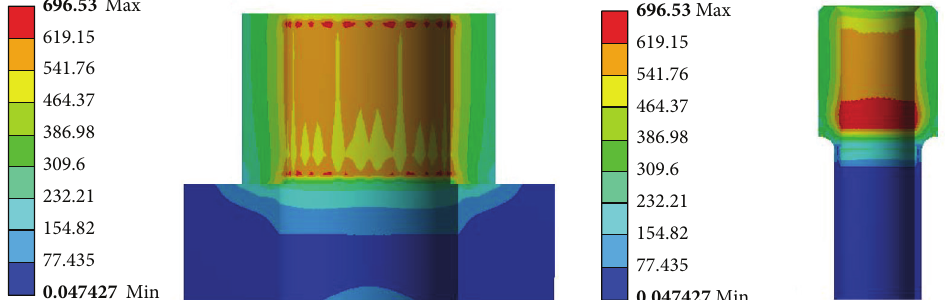
Figure 4: The equivalent stress of